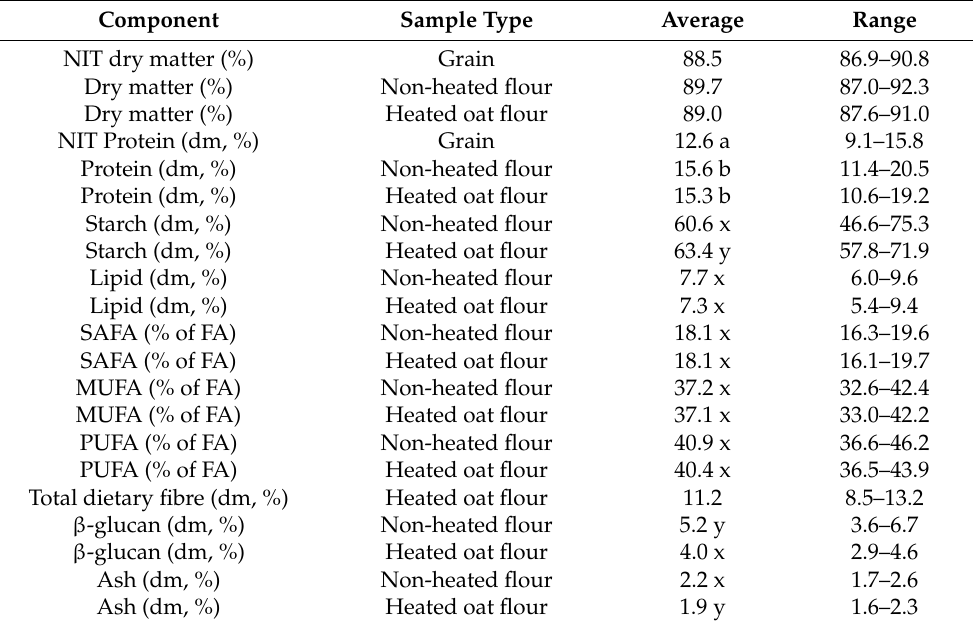
Table 3. Protein and dry matter content of 30 native oat grains, and the chemical composition of non-heated and heated oat flours as average and range